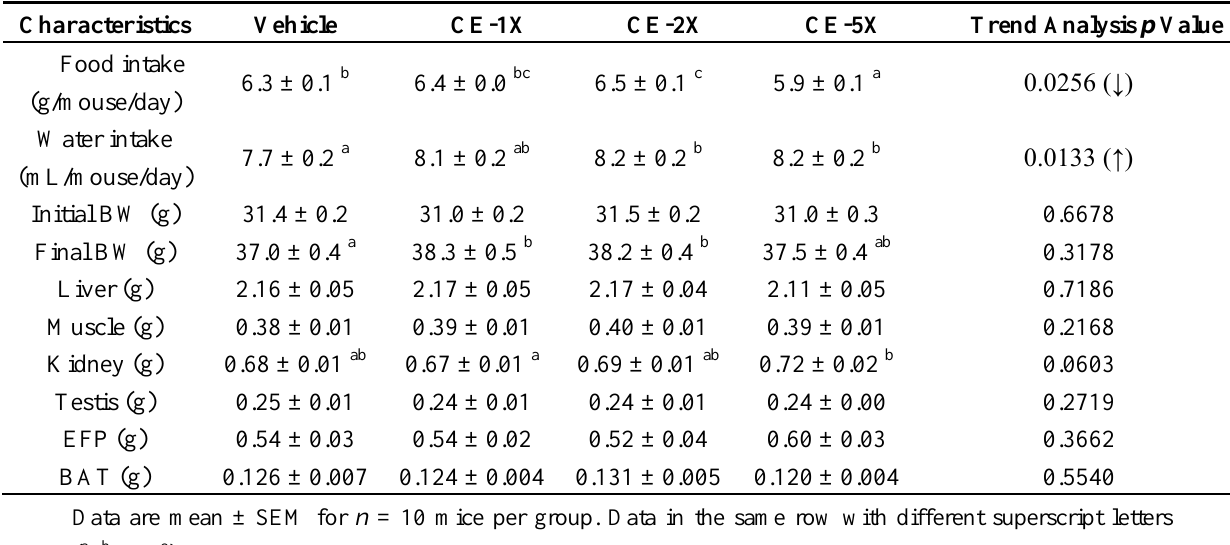
Table 1. General characteristics of mice treated with chicken essence (CE) or vehicle at the end of the